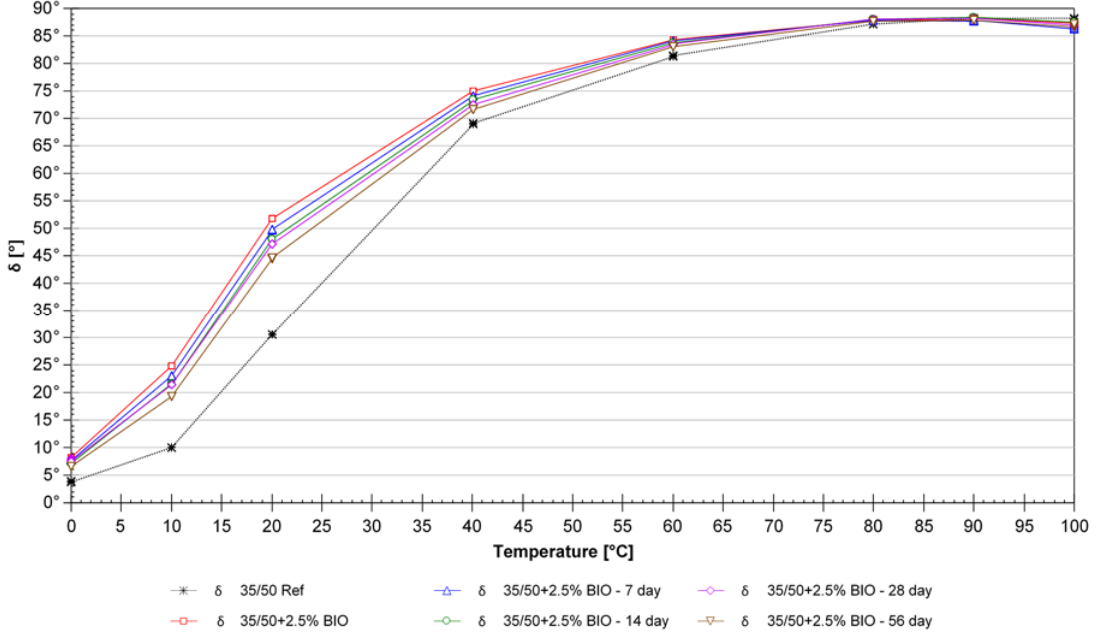
Figure 5. Changes of phase angle | δ | in time for reference bitumen and 35/50 bitumen modified with 2.5% bio ‐ agent.